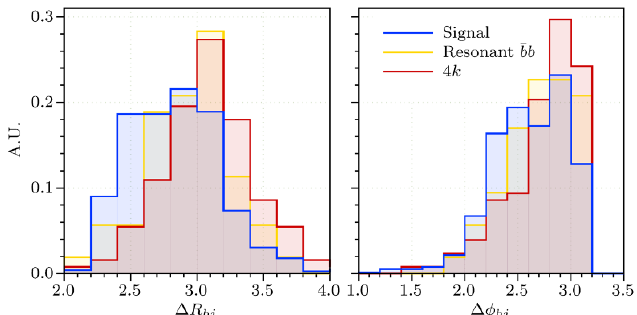
Figure 1. Normalised distributions of the (cid:1) R and (cid:1) (cid:30) separation between the b jet and the light jet reconstructing the Higgs mass after the invariant mass cuts for p s = 250 GeV with polarisation for both the signal and the two main background processes. P (cid:0) +